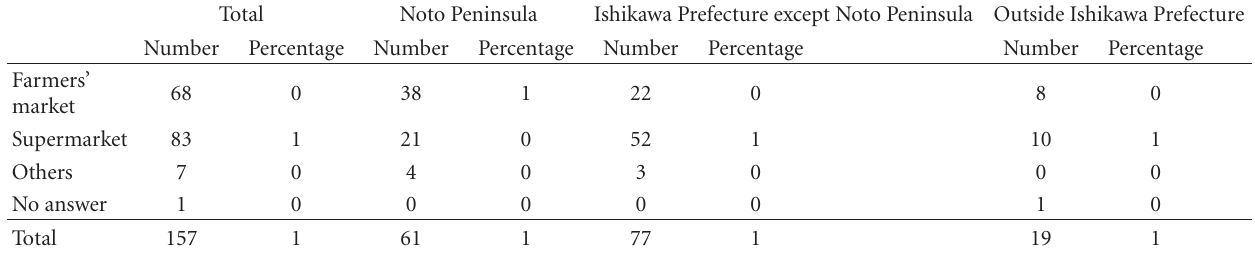
Table 6: Where do you buy the edible wild plants from?